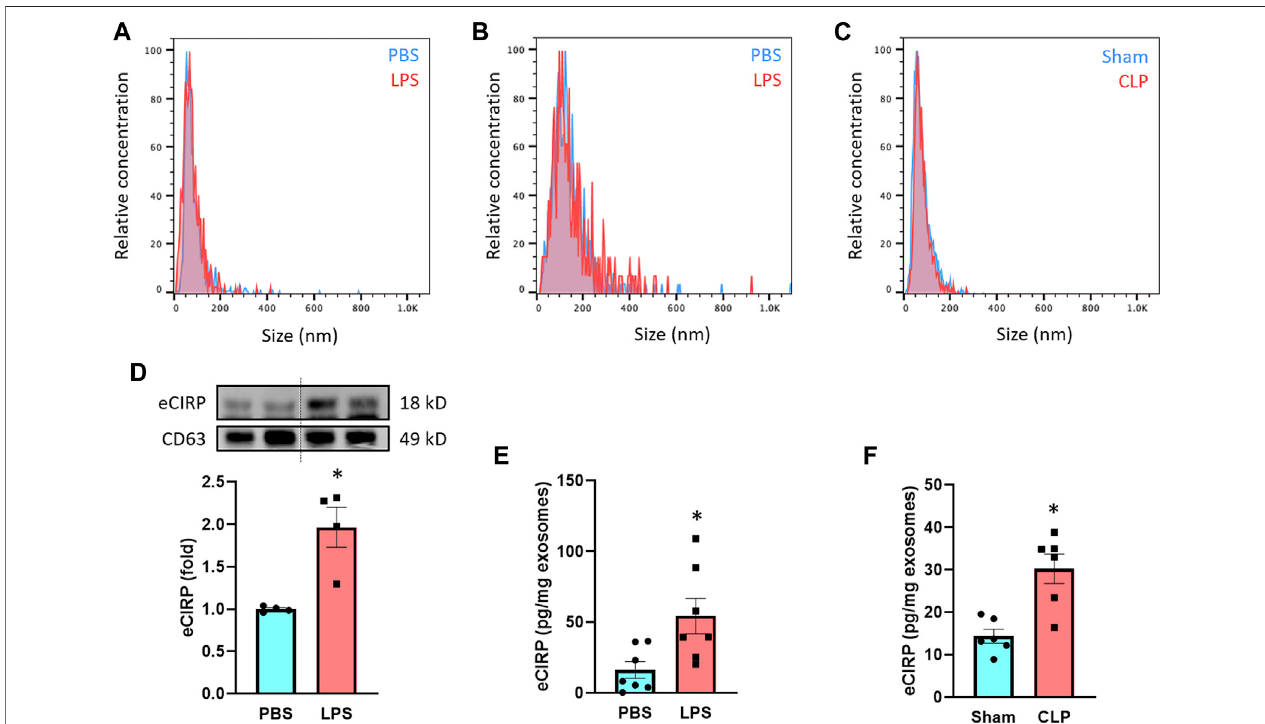
FIGURE 1 | LPS induces eCIRP release via exosomes. The size distribution of the isolated exosomes from (A) culture supernatants of PBS/LPS-treated RAW 264.7cellsandserumof (B) PBS/LPS-injectedor (C) Sham/CLPmicewasassessedbyZetaViewTWIN.Theexperimentswererepeatedthreetimes. (D) eCIRPlevelsof theexosomesisolatedfromtheculturesupernatants ofPBS-orLPS-treated RAW264.7cellsweredeterminedbyWesternblotting.RAW264.7cells(10 6 )weretreated with PBS or LPS (1 µg/ml). After 20 h of LPS stimulation, exosomes were isolated from culture supernatants. Protein contents were determined in the exosomes, andanequalamountofprotein(30 µg)wasloadedinthegeltoassesseCIRPlevelsbyWesternblotusinganti-CIRPAb.Blotswerestrippedoffandre-probedwithanti- CD63 Ab to serve as a loading control. Data are expressed as means ± SE ( n (cid:2) 4 samples/group). The groups were compared by paired student ’ s t-test (* p < 0.05 vs. PBS). (E) eCIRP levels of the exosomes isolated from the serum of PBS- or LPS-injected mice were determined by ELISA and were normalized with the protein concentration. Data are expressed as means ± SE ( n (cid:2) 7 samples/group). The groups were compared by paired student ’ s t-test (* p < 0.05 vs. PBS). (F) eCIRP levels of the exosomes isolated from the serum of sham or CLP mice were determined by ELISA and were normalized with the protein concentration. Data are expressed as means ± SE ( n (cid:2) 6 samples/group). The groups were compared by paired student ’ s t-test (* p < 0.05 vs. Sham).